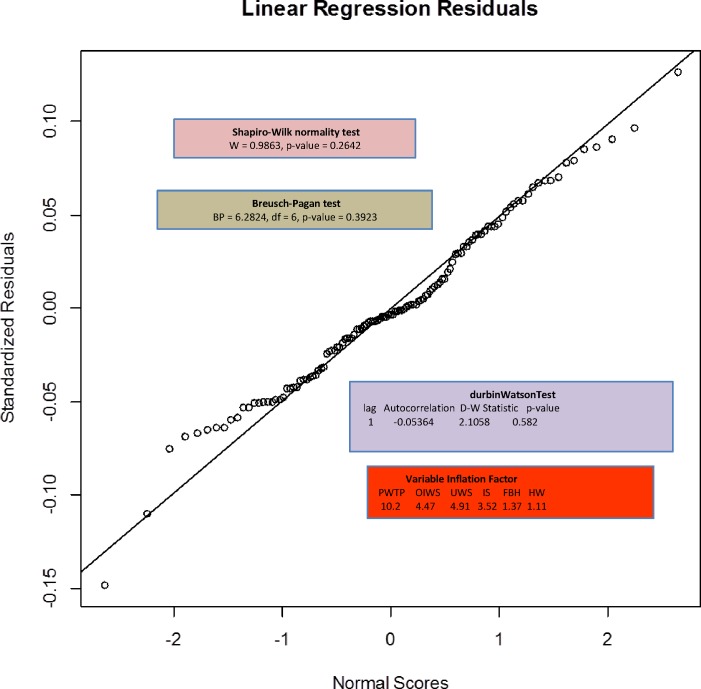
OLS Regression Results.